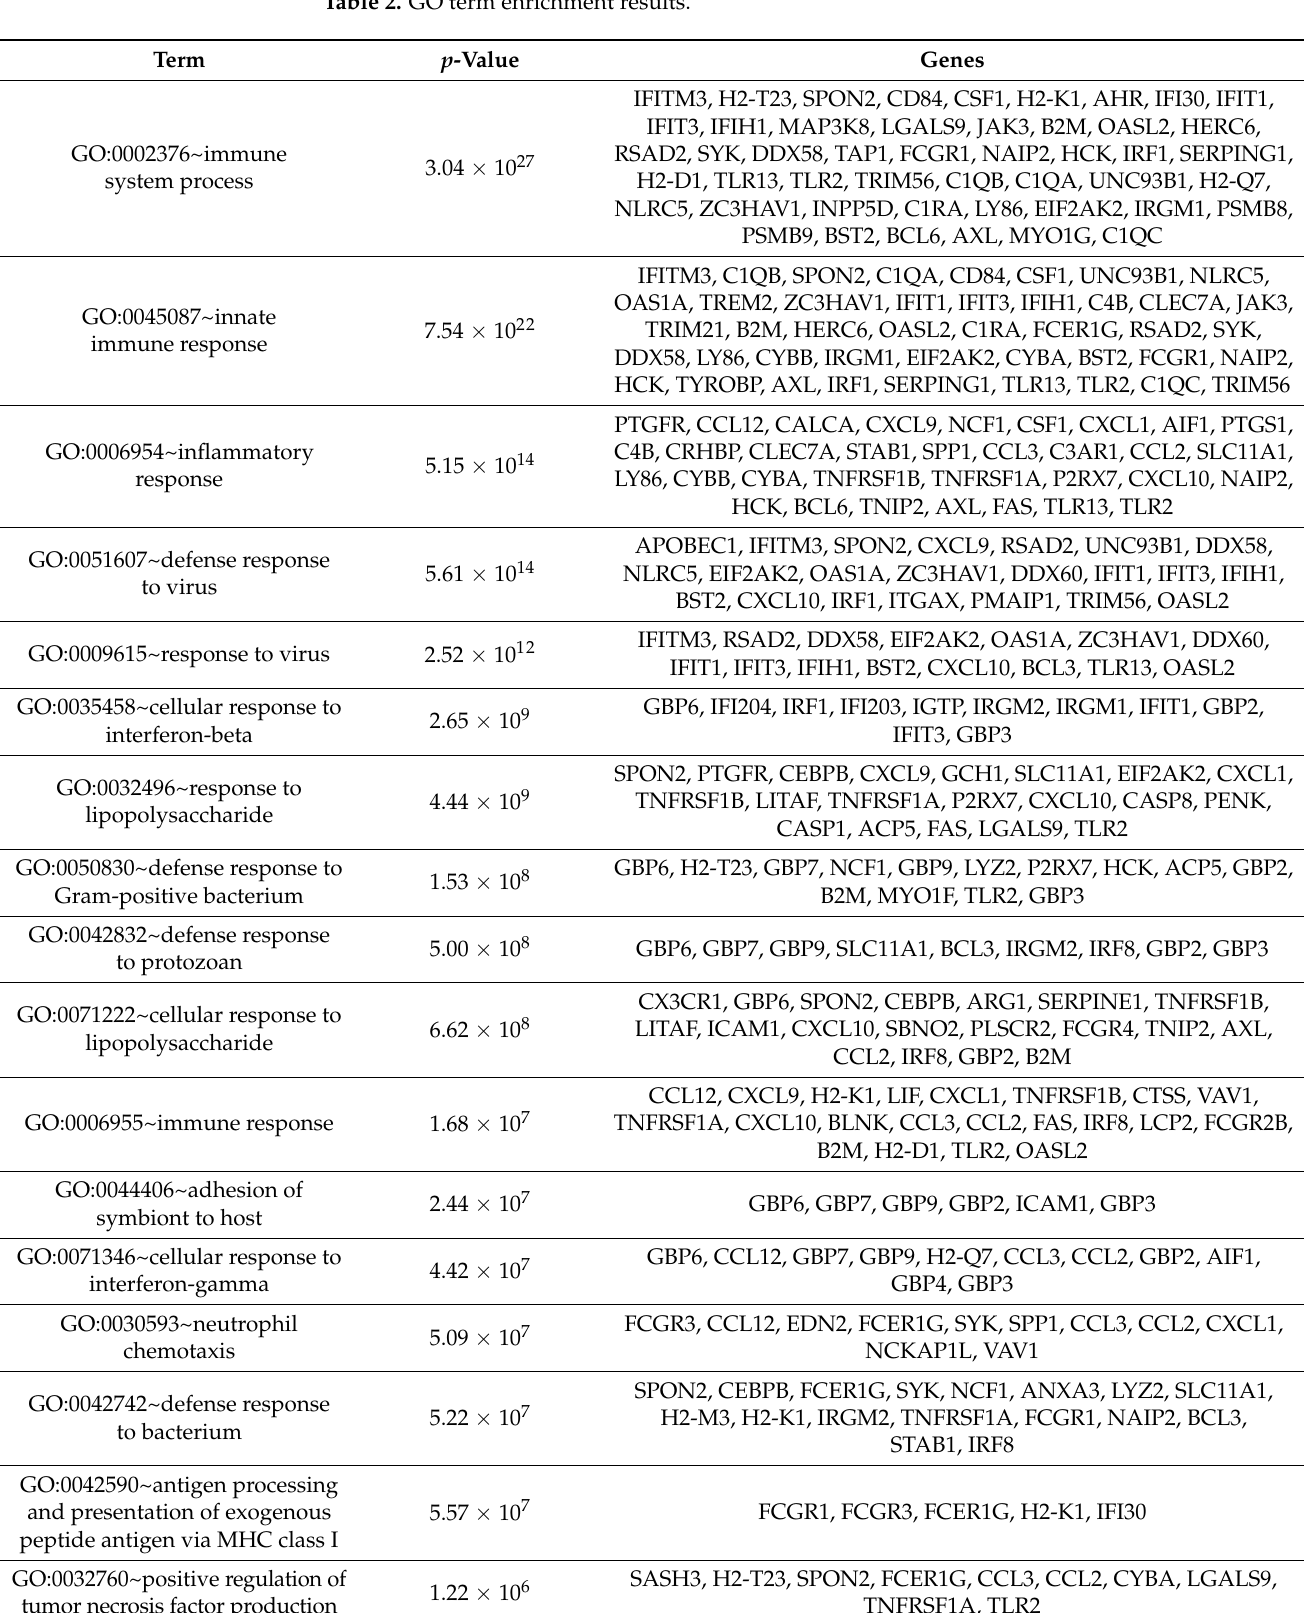
Table 2. GO term enrichment